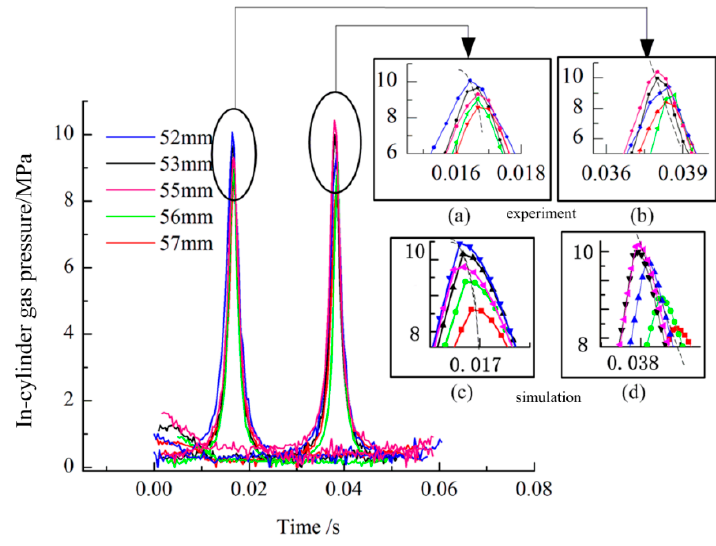
Figure 8. Experimental and simulation curves of the in-cylinder gas pressure.